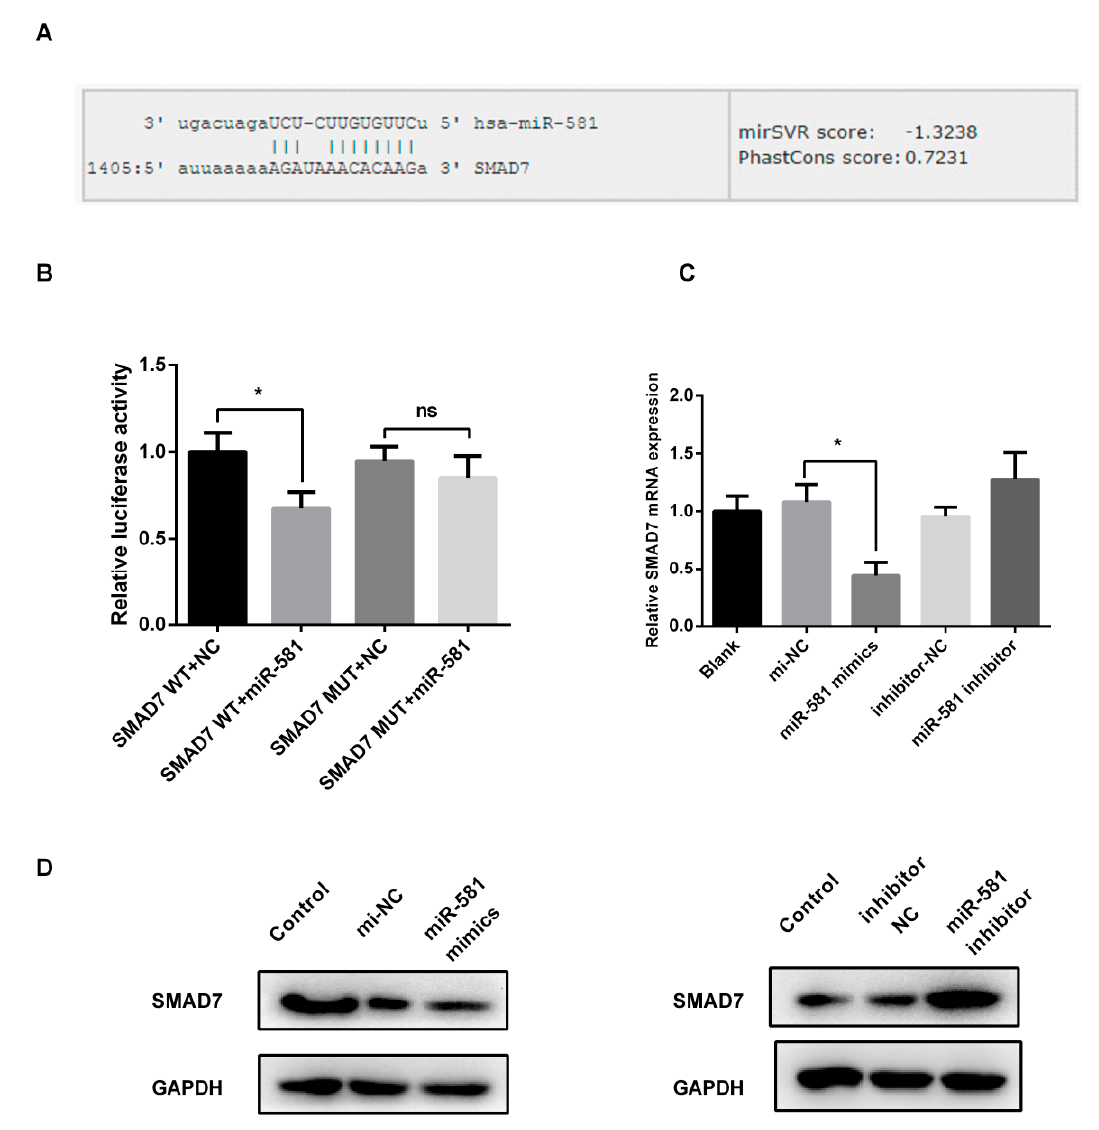
Figure 3. SMAD7 is a target of miR-581. ( A ) Binding site of miR-581 and SMAD7 3 ′ -UTR, obtained from microRNA.org. ( B ) Results of the dual-luciferase reporter assay, and relative luciferase activity of each group was shown, * p < 0.05. ( C ) mRNA analysis of SMAD7 in miR-581 overexpression and down-regulation of cells. ( D ) Protein analysis of SMAD7 in miR-581 overexpression (left) or down-regulation (right) of cells.